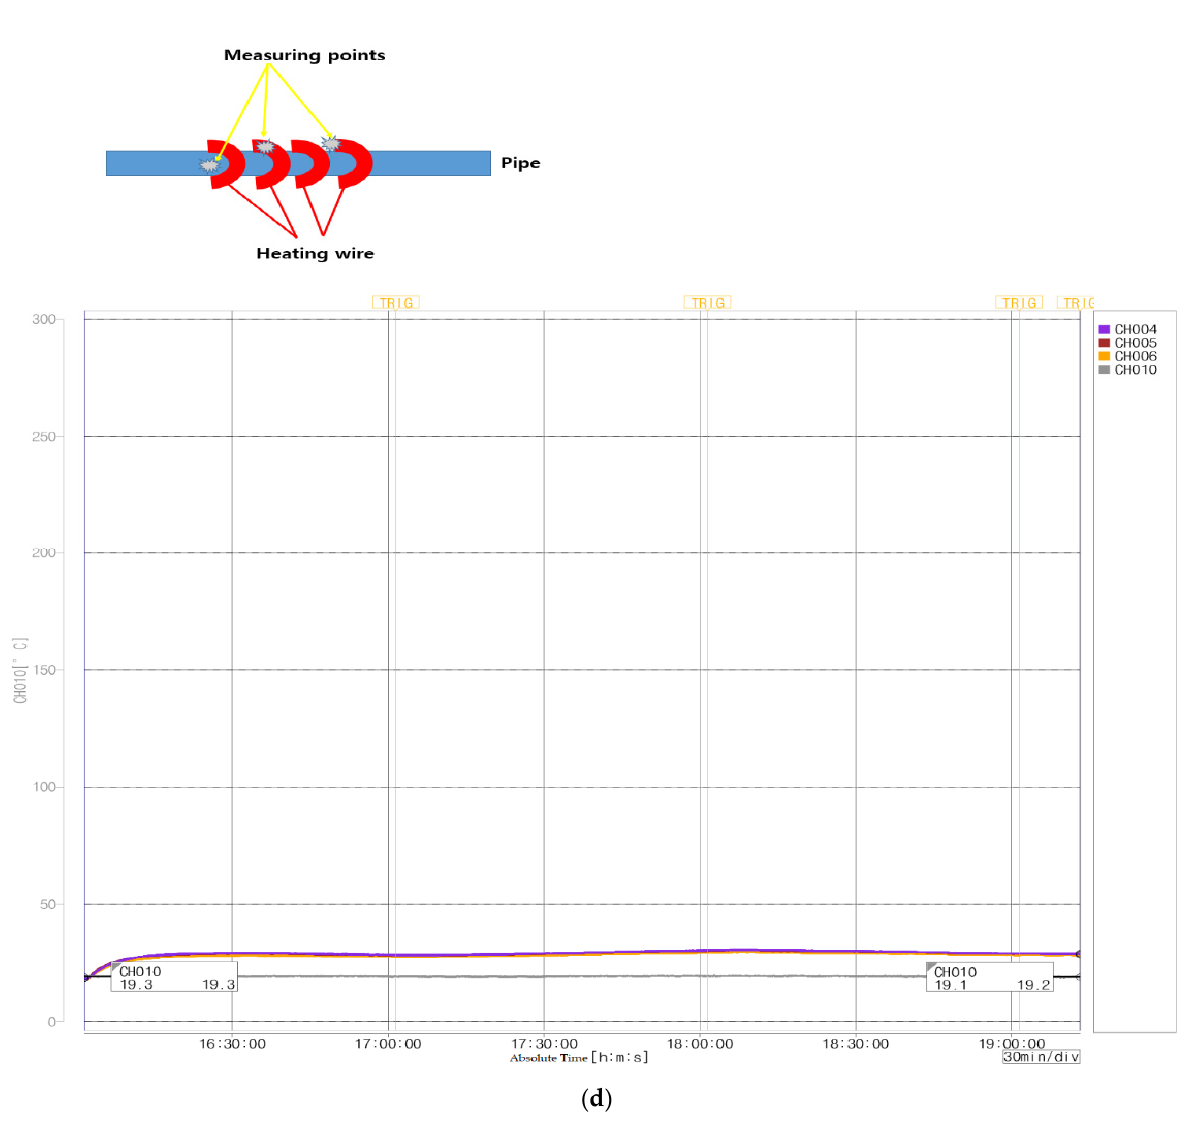
Figure 10. ( a ) Sample reproducibility test Case 1: Heating cables wrapped around water service pipes and thermal insulation or taping on the outside. ( b ) Sample reproduction test Case 2: Insulation around water service pipes and heating cables wrapped around them. ( c ) Sample reproduction test Case 3: Heating cables irregularly wrapped in multiple layers around a water service pipe. ( d ) Sample reproduction test Case 4: Sample reproducibility test: Undetectable temperature (20.0 °C).